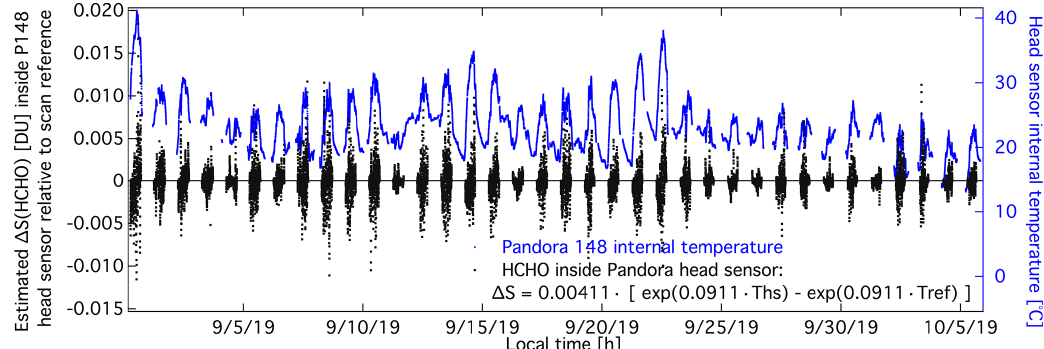
Figure 11. Estimated contribution from internally generated HCHO on the multi-axis (cid:49)S HCHO measured by Pandora 148 during TROLIX’19 using individual scan reference spectrum about 10min apart from the lowest viewing